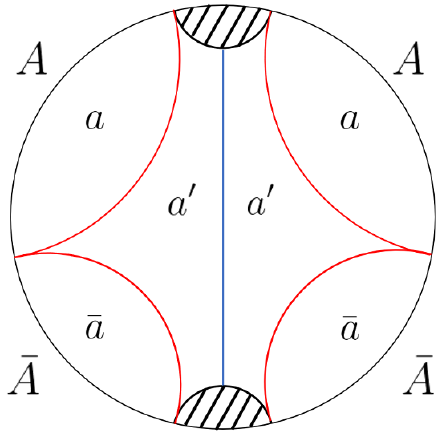
Figure 7 . A spatial slice of a two-sided BTZ black hole can be viewed as a quotient of the Poincar(cid:19)e disk. The fundamental domain is shown unshaded. We split each boundary into regions A and (cid:22) A , with an associated geodesic through the bulk (shown in red). The black hole horizon is shown in blue. Between the horizon and the geodesics (and within the fundamental region) there is a copy of region a 0 on each side. The union of these two regions is bounded by an ideal hexagon on the Poincar(cid:19)e